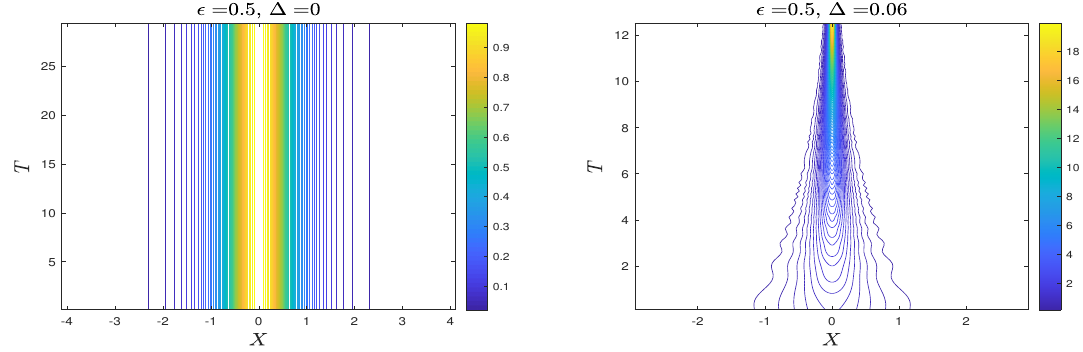
Figure 15. Case 3: The initial condition is (13) with γ = 2.0, (cid:101) = 0.5, M = 1 and ∆ = 0, ∆ = 0.06. The case when γ = 2.0, (cid:101) = 1.0 and ∆ = 0.00, 0.06 is shown in Figure 16. Here ˜ (cid:101) = 2.0 is larger and a different picture emerges, looking more like the modulation instability cases shown in Case 4 below. There is evidence of the formation of both breathers and solitons with amplitudes increasing.